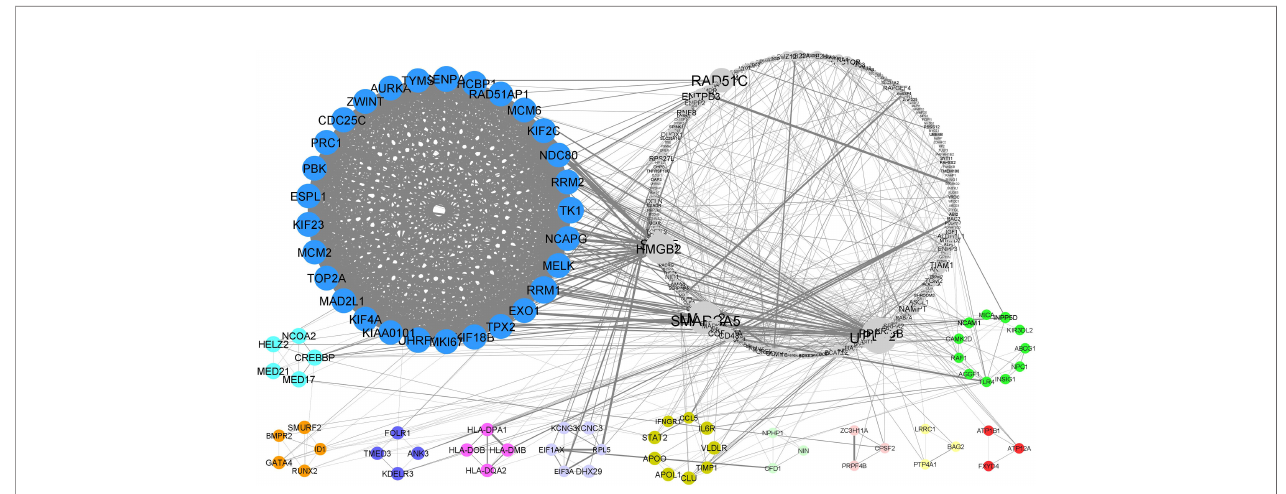
FIGURE 3 | PPI network and modular analysis of downstream genes. From STRING online database analysis, a total of 283 proteins were fi ltered into a PPI network complex. Twelve clusters were identi fi ed from Cytoscape